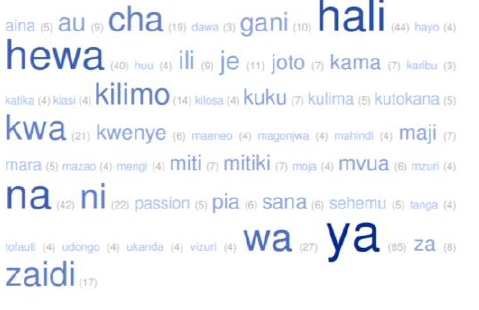
Figure 5. Word cloud after analysis using